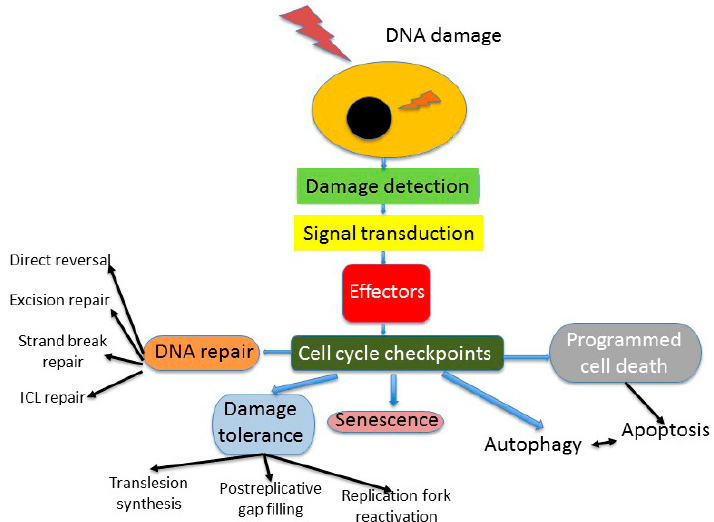
Figure 3. Some aspects of DNA damage response (DDR). DNA damage can be induced exogenously or originate from an endogenous insult. Cell cycle control is exerted only in proliferating cells, since terminally differentiated, quiescent and senescent cells, as well as some other kinds of cells, do not present this control. Stem cells can display some other kinds of DDR, programmed cell death is represented only by apoptosis, for which association with autophagy is not fully